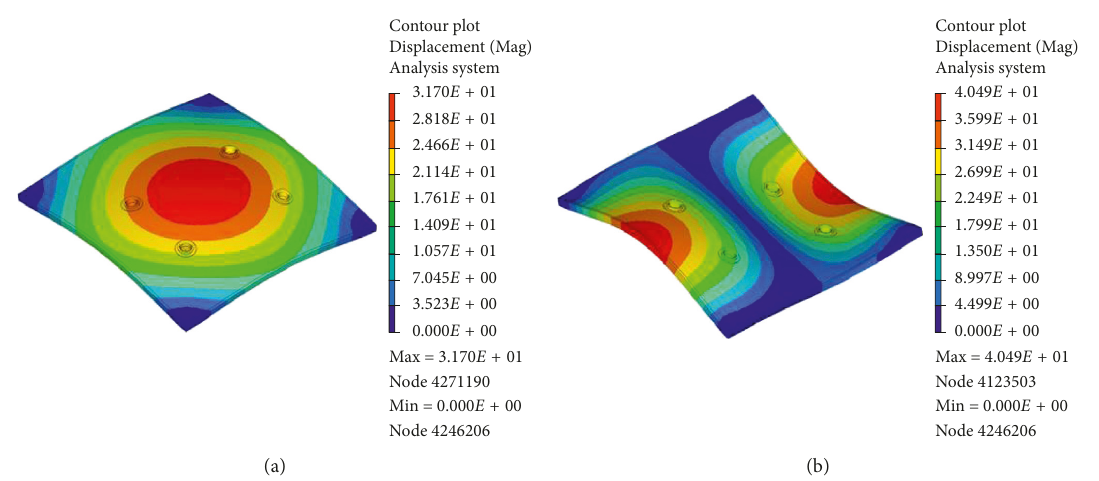
Figure 3: Simulation analysis of the mode shape. (a) First mode shape. (b) Second mode shape. Honeycomb sandwich panel